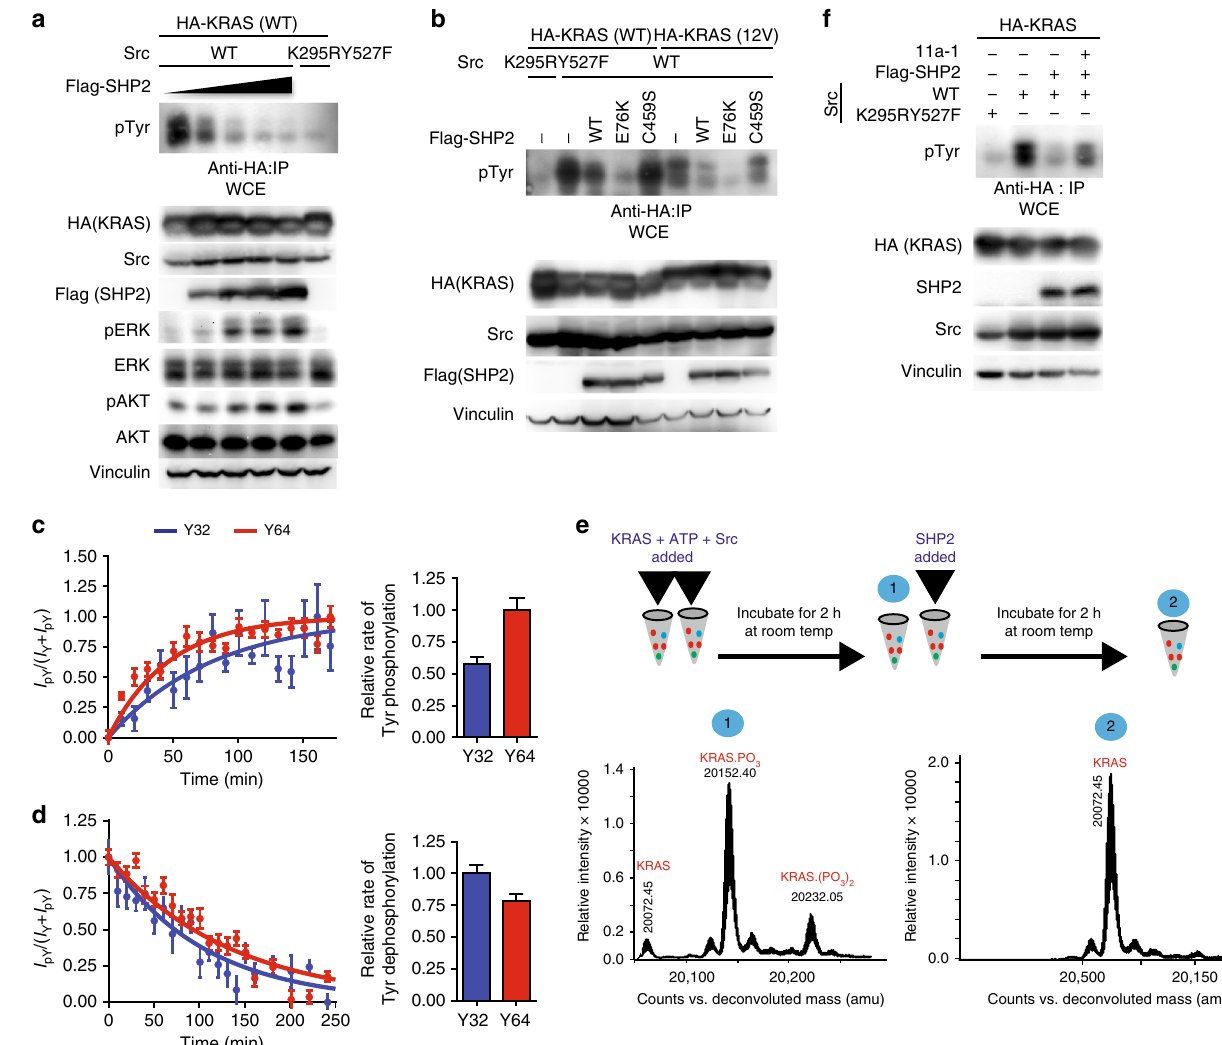
Fig. 3 SHP2 dephosphorylates tyrosyl phosphorylated KRAS. a , b HEK293 cells were transfected with the indicated plasmids. Cells were lysed, immunoprecipitated, and immunoblotted with the indicated antibodies. c Phosphorylation was initiated by addition of 2 μ M of Src to 250 μ M of KRAS in the presence of 2 mM ATP and 1 mM activated sodium vanadate. Sequential 1 H- 15 N HSQC NMR spectra were collected, and peaks from un-phosphorylated and phosphorylated Tyr32 (blue) and Tyr64 (red) were integrated from each spectrum to plot curves of the fraction phosphorylated vs. time for each site. The error bars correspond to the noise-to-signal ratio of the respective peaks. The relative rates of phosphorylation of each site determined from a representative experiment (performed in duplicate) by curve fi tting are shown in histograms on the right. The error bars indicate the standard curve fi tting error obtained from the fi tting analysis. d SHP2 (2 μ M) was added to Src-phosphorylated KRAS sample puri fi ed in the presence of vanadate, and sequential 1 H- 15 N NMR spectra were collected to monitor dephosphorylation. Similar to c , the fractions of phosphorylated Tyr32 (blue) and Tyr64 (red) were plotted and rates of dephosphorylation were determined and are shown in the histograms. Rate curves from a representative experiment (performed in duplicate) were fi tted to one phase exponential decay/association functions using the GraphPad Prism 4.0 software. Histogram error bars indicate the standard curve fi tting error obtained from the fi tting analysis. e Top panel; experimental set-up whereby two tubes containing 200 μ M of KRAS and 3 μ M of Src were incubated in in the presence of 2 mM ATP for 2 h (in the absence of vanadate). Sample 1 was then snap frozen and stored at − 80 °C for MS analysis, and 3 μ M of SHP2 was added to the remaining tube and incubated for an additional 2 h. Sample 2 was then frozen. Bottom panels; MS spectra of samples 1 and 2 with phosphorylation state of each mass indicated. f HEK293 cells transfected with the indicated plasmids were treated with ( + ) or without ( − ) 10 μ M of 11a-1, lysed, immunoprecipitated, and immunoblotted with the indicated antibodies. The immunoblot data are representative of at least three independent